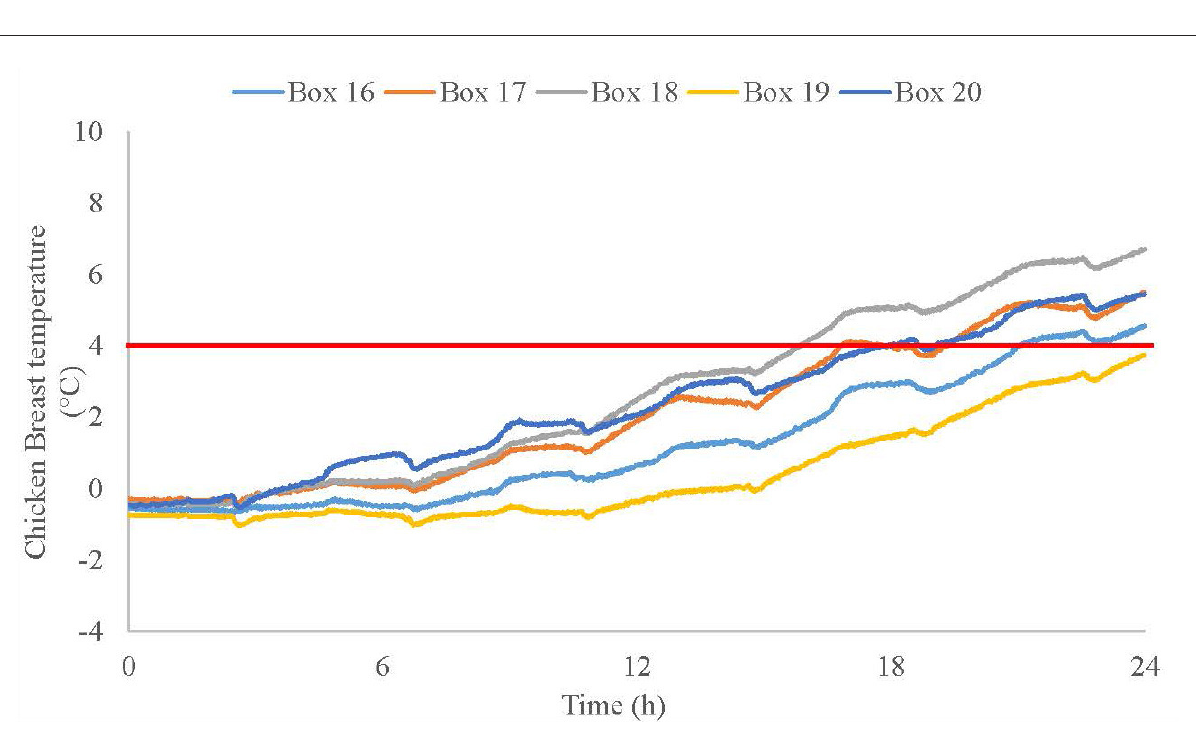
most TA box were stacked at the same location of the pallet (Figure 6). In layer 1, after only 9.68 h there is already a box that has crossed into the temperature “danger zone.” While in the middle layers (layers 2 and 3) 8 of 10 boxes never